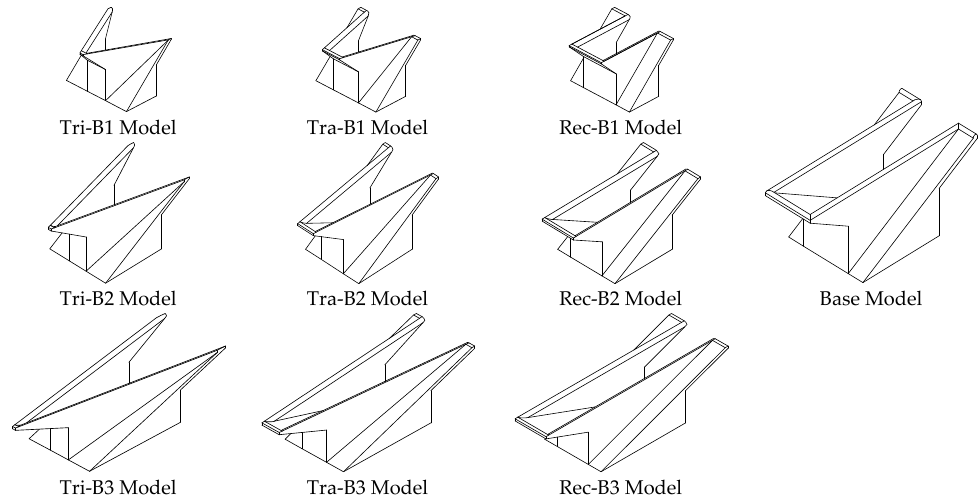
Figure 4. A Three-dimensional view of the tested models (1 key, downstream view). Table 1. Different data measurements (denoted by the ■ Symbol) for PKW Models with various apex width ratios ( A / w ) and length magnification ratios ( B / w ).